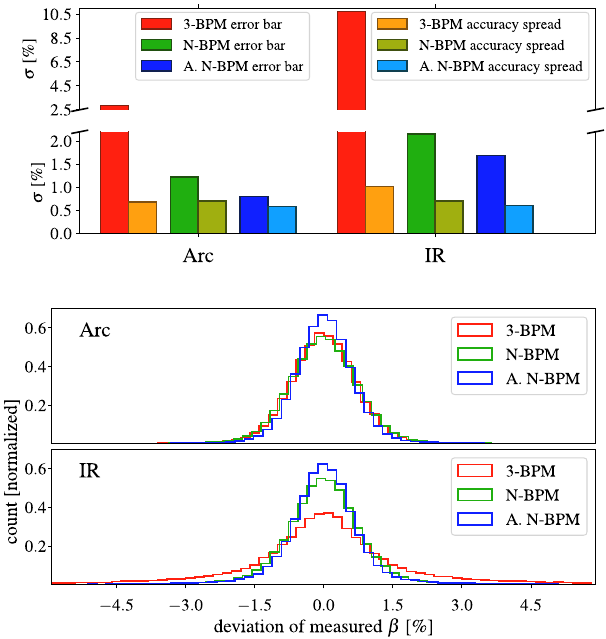
FIG. 5. Comparison of the 3-BPM method, the original N-BPM method and the analytical N-BPM method (denoted as A.N-BPM ) for the nominal LHC lattice at collision, with β (cid:1) ¼ 40 cm. Bottom: histogram of the difference to the real β -function in percent. Top: the average of the error bars and the accuracy spread (width of a standard distribution fit to the distribution in the bottom plot) in percent. The analytical N-BPM method has the best accuracy both in the arcs and in the IRs. Data have been cleaned of